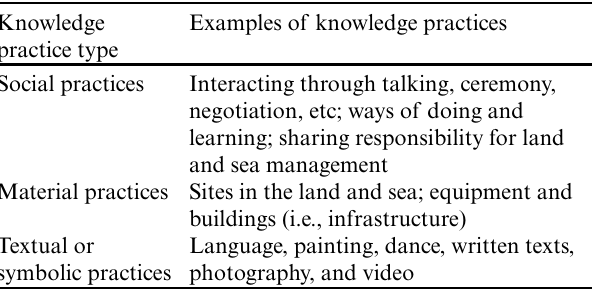
Table 1 . Typology of knowledge practices (adapted from Shapin and Schaffer